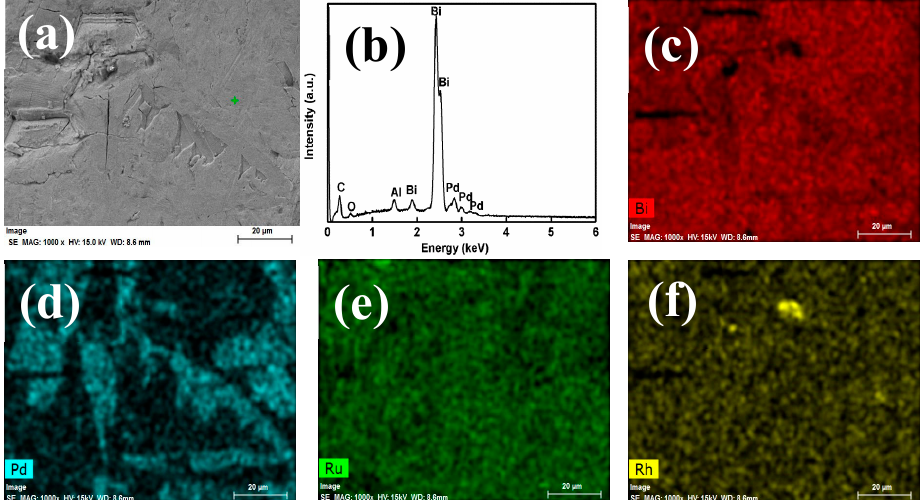
Figure 4. ( a ) FE-SEM image, ( b ) EDS analysis for the recovered liquid Bi metal from the batch 2 and the corresponding elemental mapping: ( c ) Bi; ( d ) Pd; ( e ) Ru; ( f ) Rh.